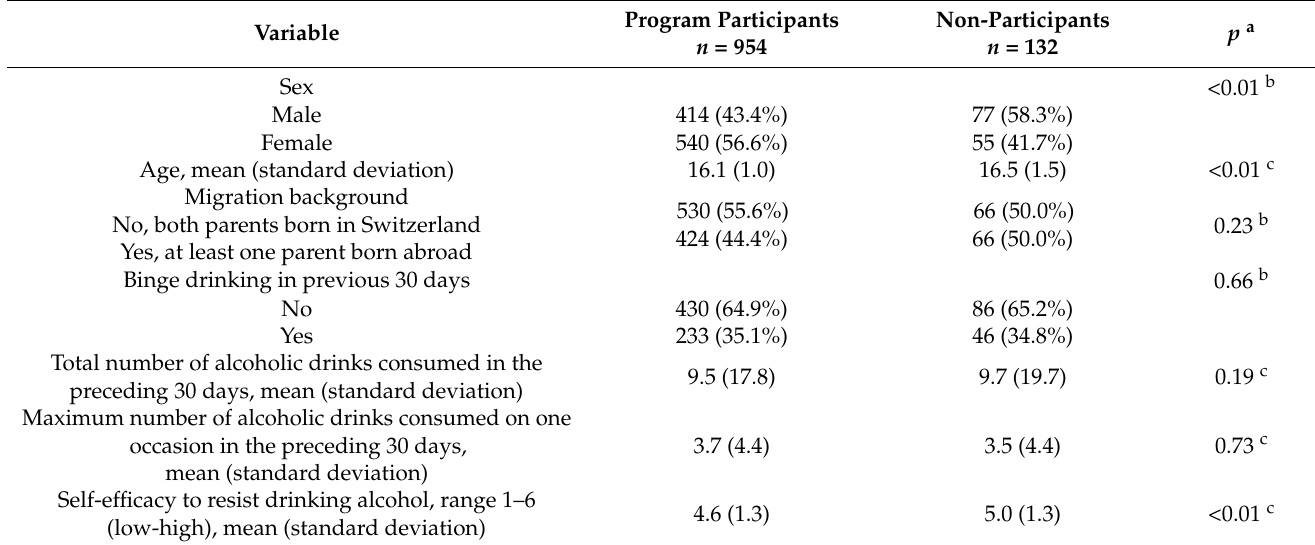
Table 2. Baseline characteristics of the program participants and non-participants. Values represent n (%), unless stated